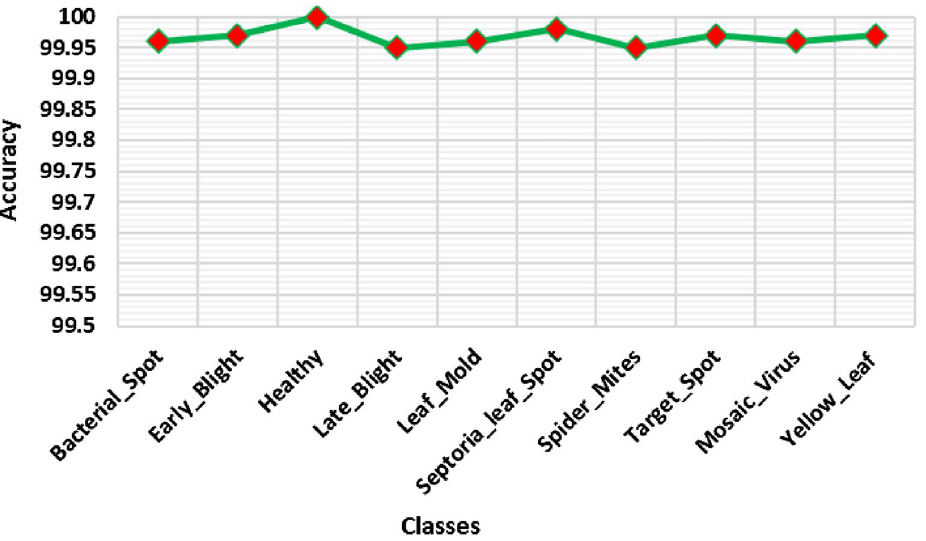
Figure 11. Line plot of accuracy